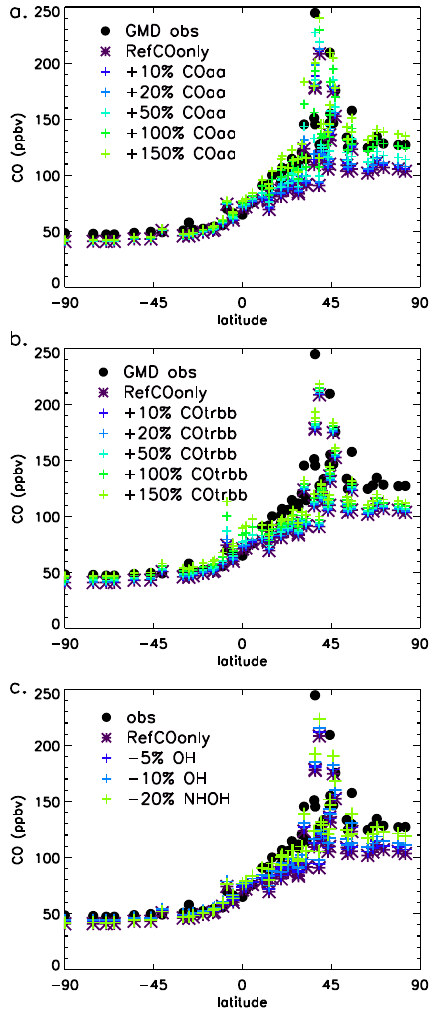
Figure 3. Latitudinal distribution of CO observations from the GMD network (black circles) and simulated CO from the Ref- COonly simulation (purple stars) averaged over March–August. Blue–green + signs indicate the effect of (a) increasing the Asian anthropogenic CO tracer, (b) increasing the tropical biomass burn- ing CO tracer, and (c) decreasing OH globally by 5 or 10%, or decreasing NH OH by 20%.